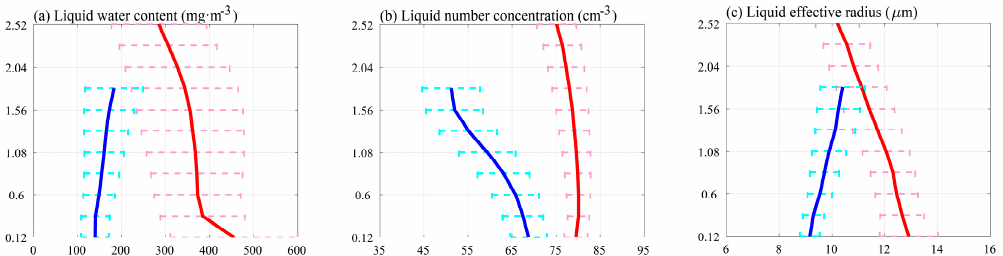
Figure 6. The profiles of mean microphysical properties including liquid water content ( a ); liquid number concentration ( b ) and liquid effective radius ( c ) of PS (red solid curves) and NPS (blue solid curves) clouds. The standard deviations are displayed in short dashed horizontal lines in pink and cyan for PS and NPS clouds, respectively. The vertical coordinate-axis Y is the height (km) above cloud base.